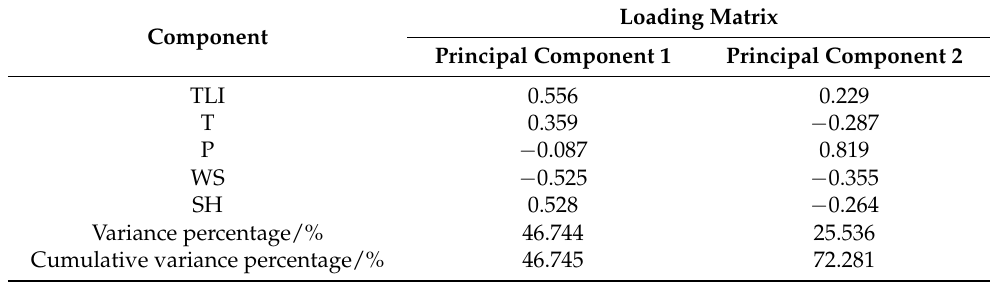
Table 1. Principal component loading